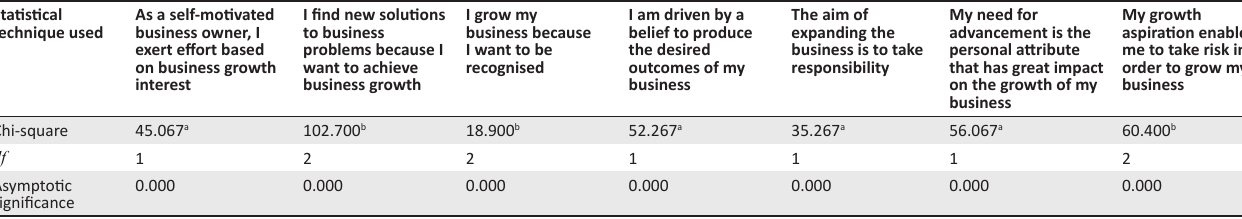
TABLE 6: Chi-square statistics of intrinsic motivational factors for small and medium enterprise growth. Statistical technique